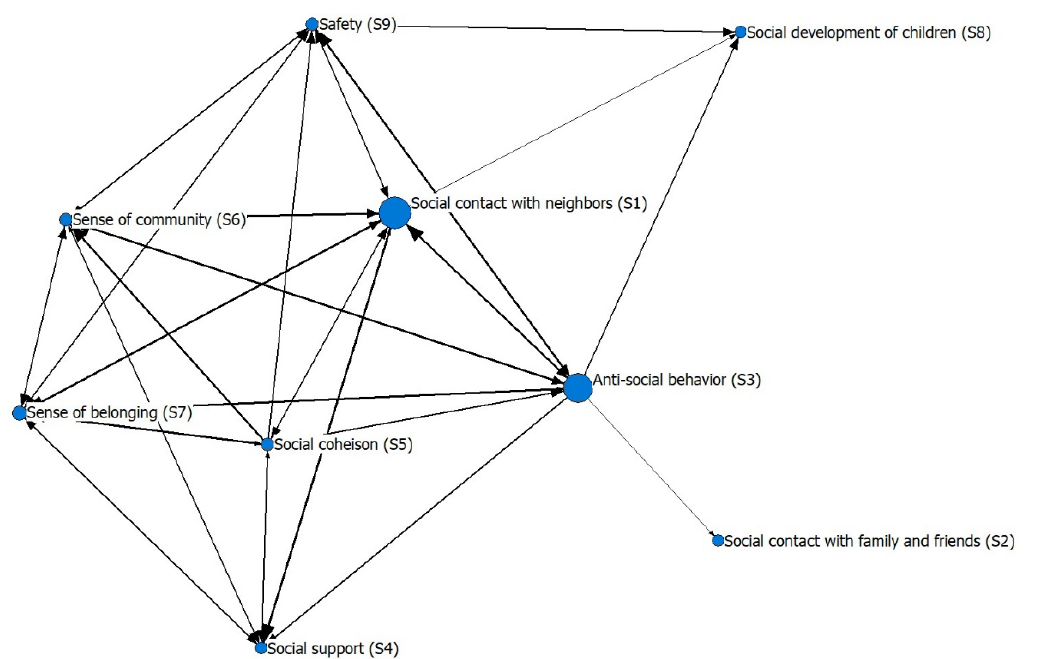
Figure 4. Causal relations map.